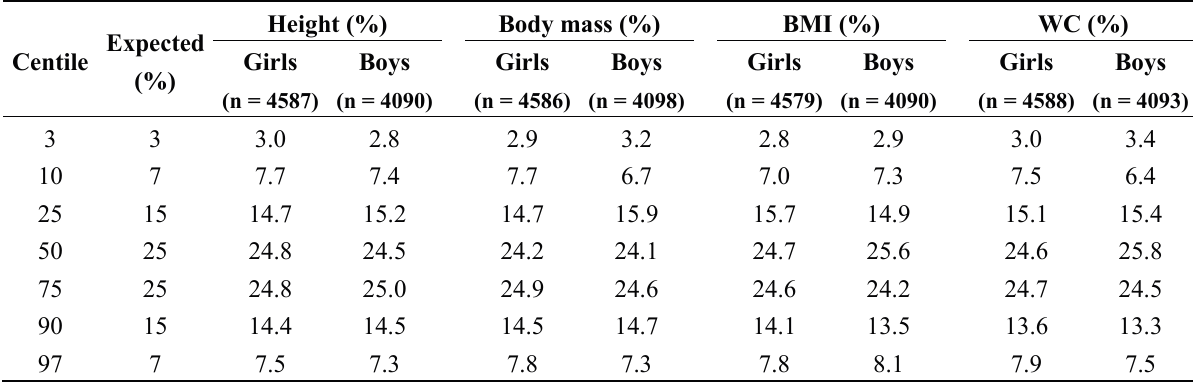
Table 3. Distribution of Z-score of height, body mass, BMI and waist circumference for the Peru sample compared to expectation assuming normality-area between adjacent centiles